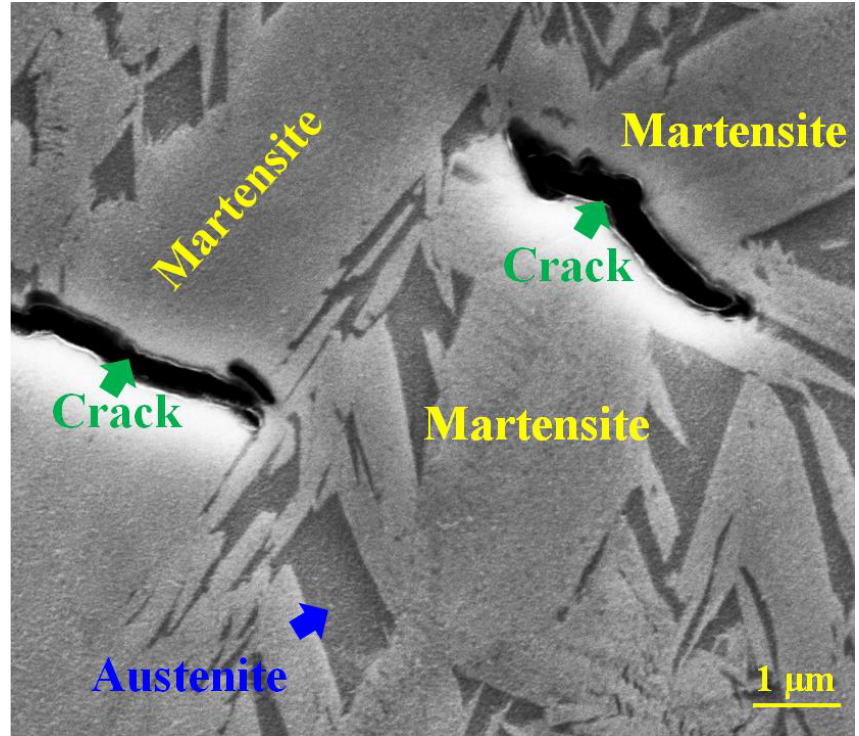
Figure 8. SEM image of the martensite structure in a quenched cast iron sample. The cracks with dark contrast appeared in martensite.